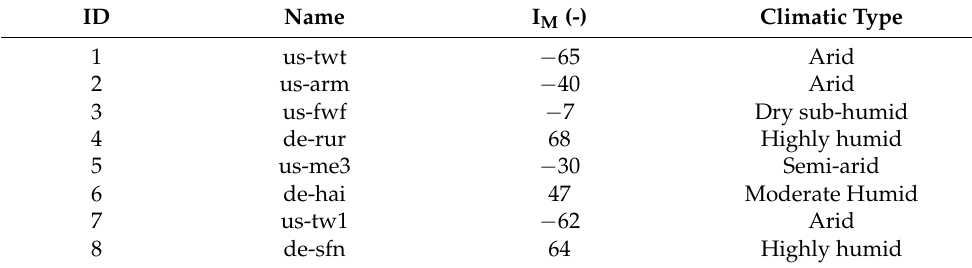
Table 4. Value of the moisture index for each